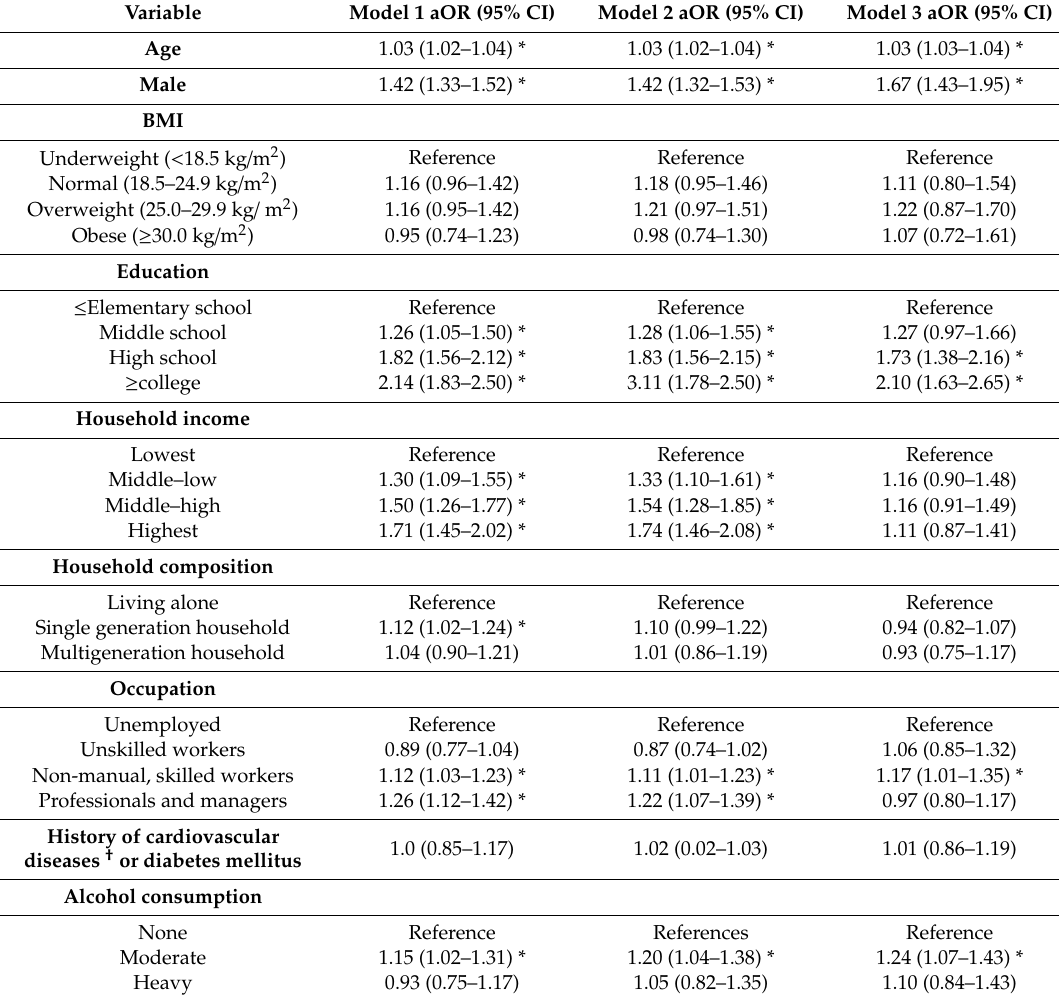
Table 4. Sociodemographic and dietary factors associated with frequent peanut consumption in